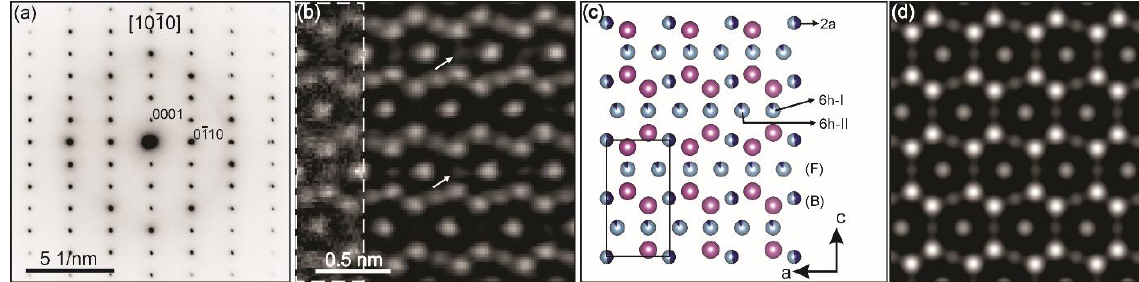
Figure 7. TEM studies of the Al 2 − x Cr x Sc ternary phase: ( a ) SAED pattern analysis with the corresponding ( b ) atomically- resolved HAADF-STEM image. ( c ) Projected atomic model of the ternary phase, viewed in the [101̅0] zone axis with the related ( d ) calculated HAADF-STEM image.